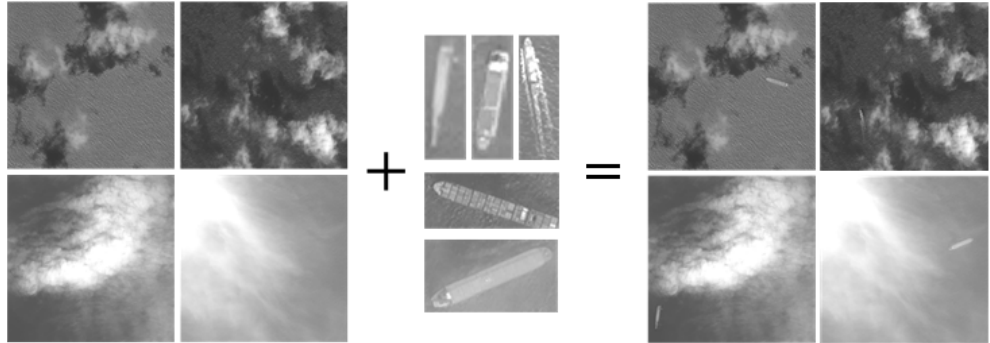
Figure 6. Schematic diagram of simulation sample production with randomly added different types of ships in the background in order to obtain augment